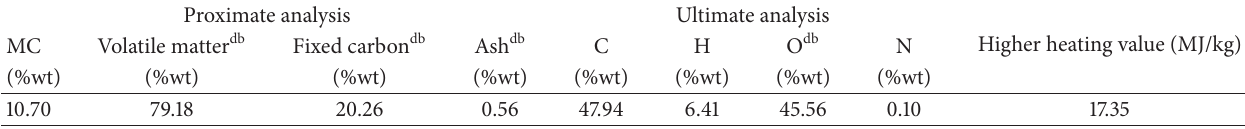
Table 1: Proximate, ultimate analysis, and higher heating value of biomass materials. Proximate